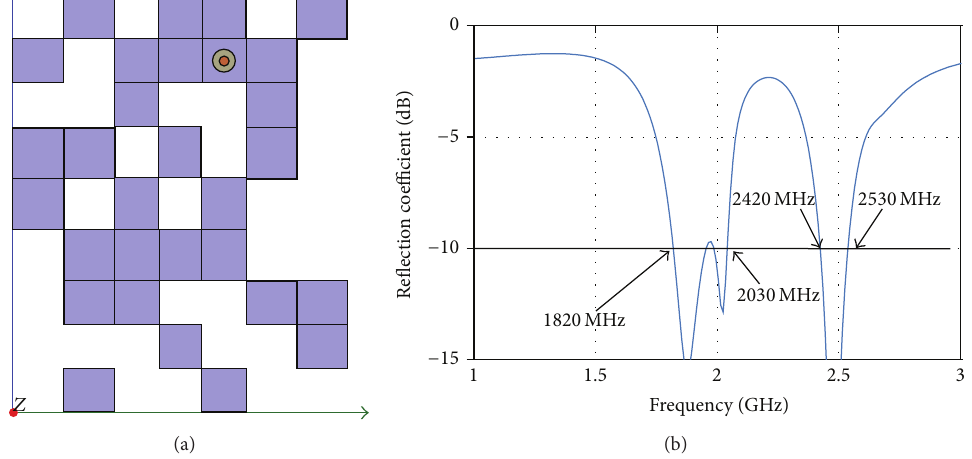
Figure 3: The optimized MPA with infinitesimal connections. (a) Optimized design. (b) Reflection